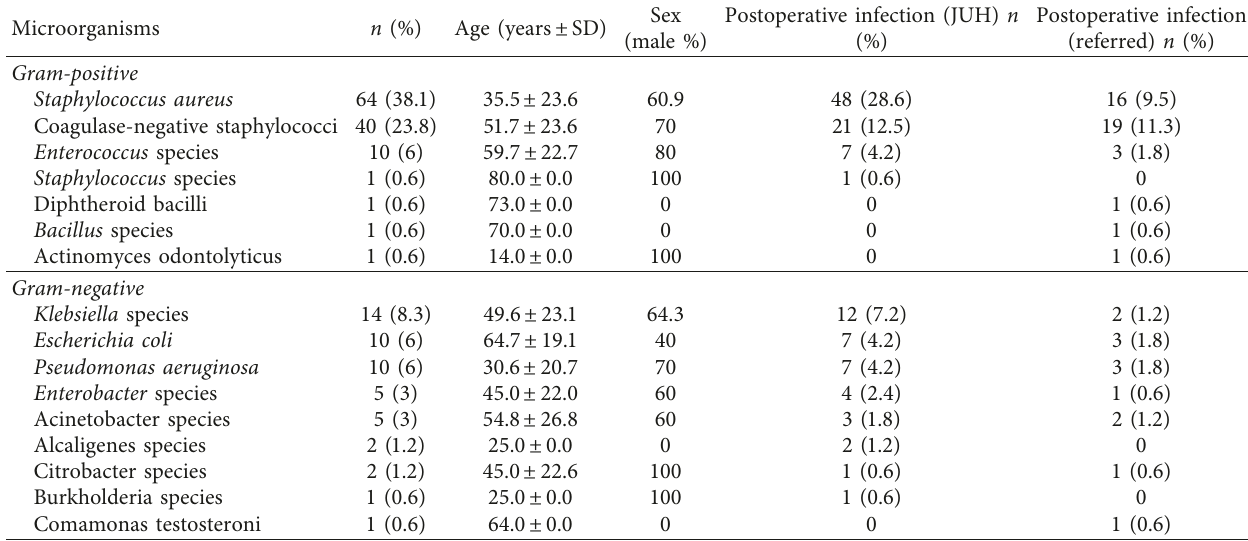
Table 2: Frequency of bacteria in infected